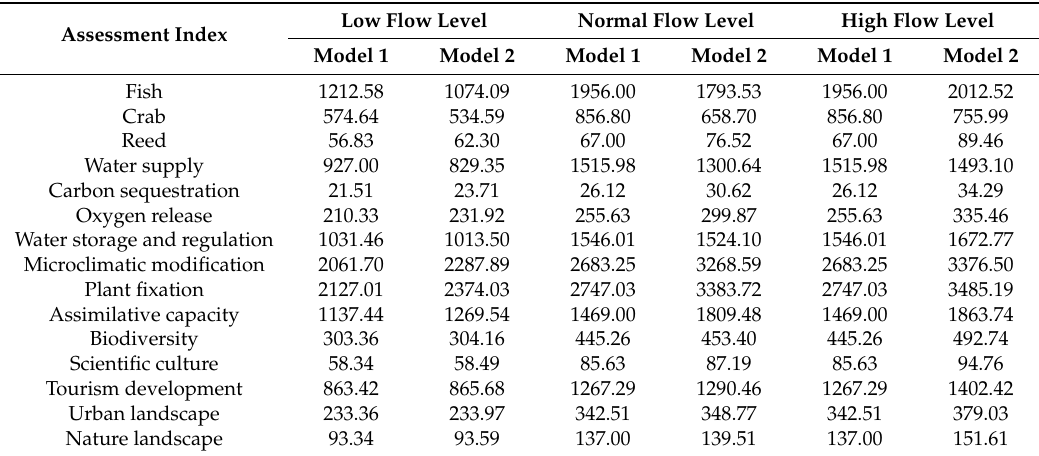
Table 7. Comparison of incremental ecological service values based on assessment indexes (million